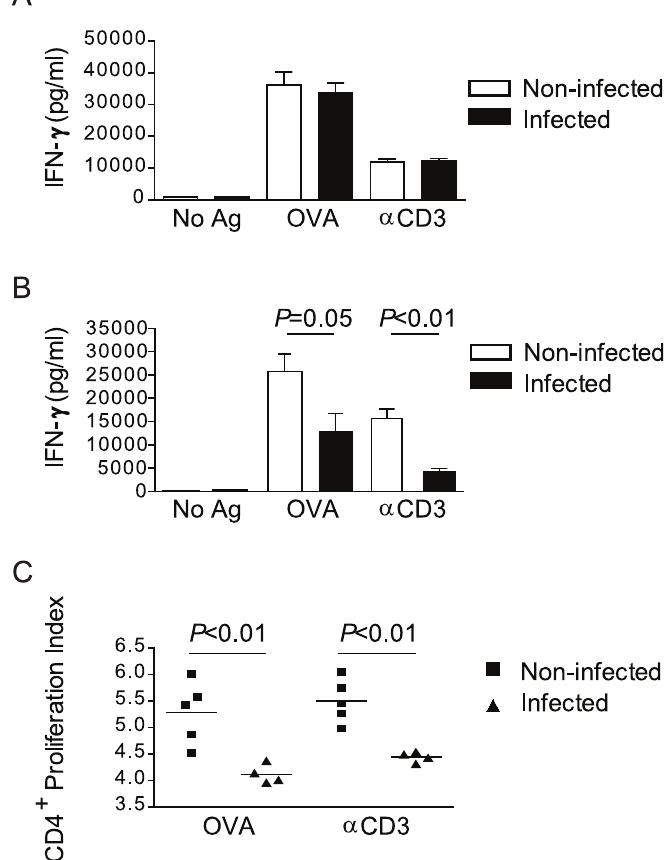
Figure 4. Pre-patent schistosome infection impairs the ability of CD11b + cells to stimulate CD4 + cells. A, CD11c + dendritic cells isolated from the spleen of 4 week S. mansoni -infected or non-infected wild type mice and CD4 + T cells isolated from non-infected OT-II/RAG-1 2 / 2 mice were co-cultured for 72 hours without antigen, with OVA peptide or with anti-CD3 antibody. The concentration of IFN- c in the cell culture supernatants was measured by ELISA. B, CD11b + cells were isolated from the spleens of 4 week S. mansoni -infected or non-infected OT-II/RAG-1 2 / 2 mice; CD4 + T cells were isolated from non-infected OT-II/RAG-1 2 / 2 mice, and stained with CFSE. Cells were then co-cultured for 72 hours without antigen, with OVA peptide or with anti-CD3 antibody. The concentration of IFN- c in the cell culture supernatants was measured by ELISA. Data shown are mean + / 2 SEM. C, CD4 + T cell proliferation in the co-cultures stimulated with OVA peptide or anti-CD3 antibody described in (B) was analyzed by flow cytometry and proliferation index calculated. Horizontal bars represent mean of 5 independent mice. No Ag, no antigen; OVA, OVA peptide; a CD3, anti-CD3.